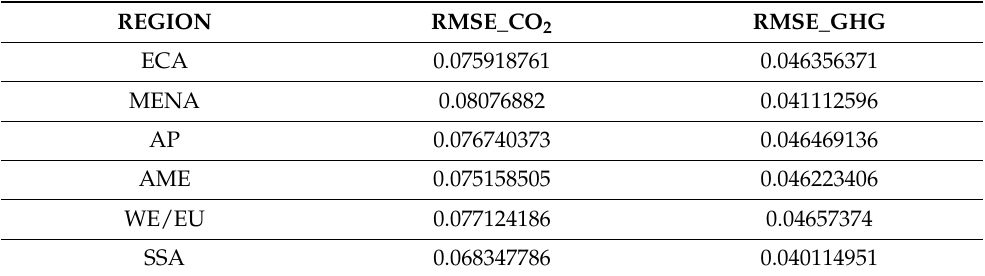
Table 5. The Root Mean Square Errors of CO 2 and GHG emissions for the six regions of the sample (period from 2010 to